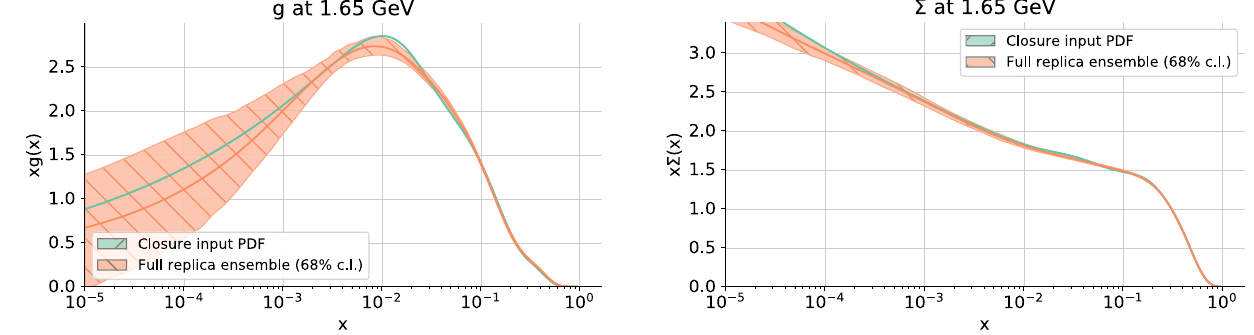
Table 24 The expectation value of (cid:17) χ 2 , Eq. (6.9), evaluated over the n fit fits that constitute the NNPDF4.0 closure test. Results are presented separated into different processes